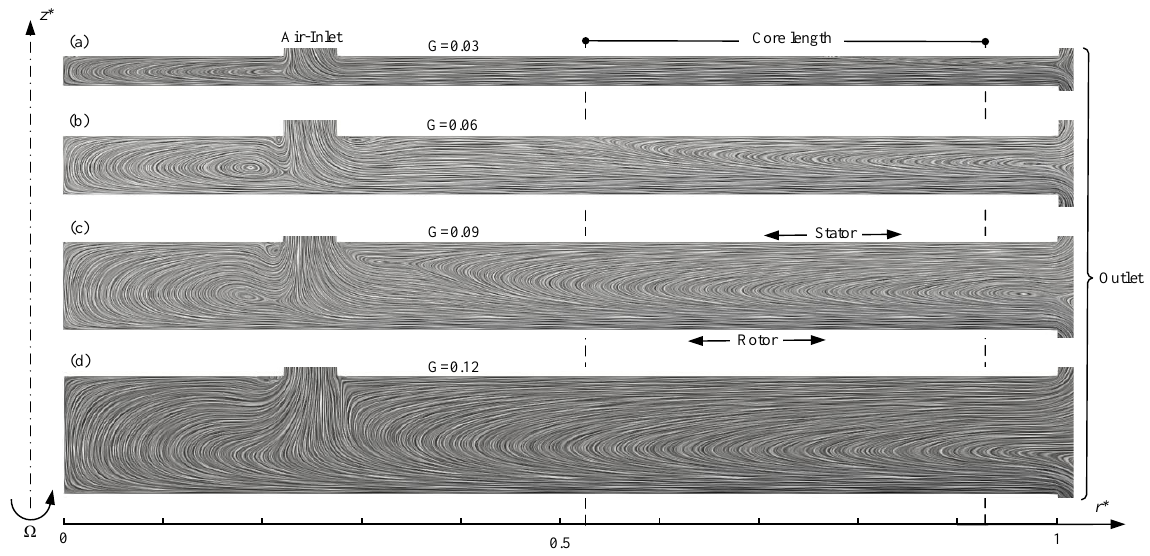
Figure 17. Line Integral Convolution (LIC) representation of the flow structure inside the AFPM machine for a fixed Reynolds number Re = 5513 with an air-inlet. ( a – d ) correspond to different gap-length ratios G. Use is made of two dimensionless length scales, z ∗ = z / d and r ∗ = r / R , where d is the gap-length and R the outer